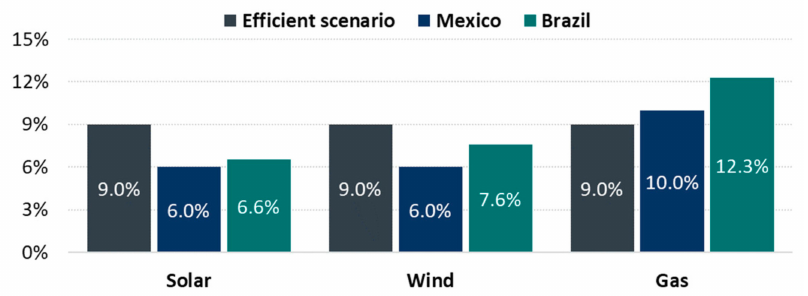
Figure 4. Pre-tax WACC for Brazil and Mexico in the current and efficient regulation